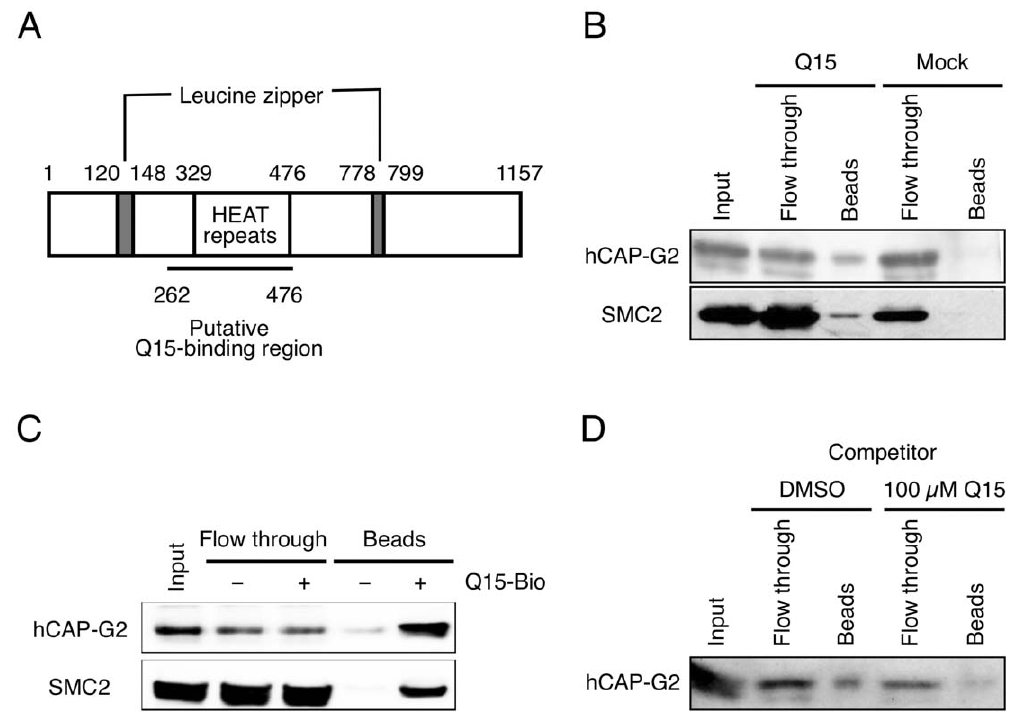
Figure 4. hCAP-G2 protein interacts directly with Q15. (A) Domain structure of hCAP-G2. The region (262–476) selected by mRNA display is underlined. (B and C) Lysates from KMS34 (B) and SW480 (C) cells were incubated with Q15-immobilized beads for 2 h. Each fraction was subjected to 10% SDS-PAGE. Protein bands were detected by immunoblotting with antibodies against hCAP-G2 and SMC2. (D) Cell lysates from KMS34 cells were incubated with Q15-immobilized beads for 2 h in the absence or presence of 100 m M free Q15. Each fraction was subjected to 10% SDS-PAGE and protein bands were detected by immunoblotting with antibodies against hCAP-G2.